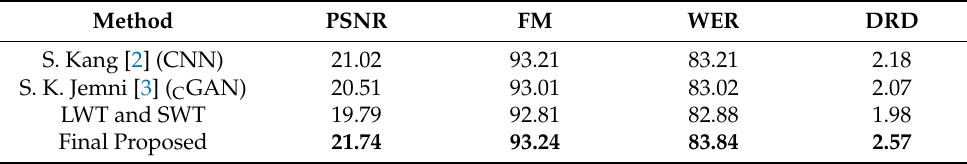
Table 5. Comparative results on Tobacco 800 [31] dataset.